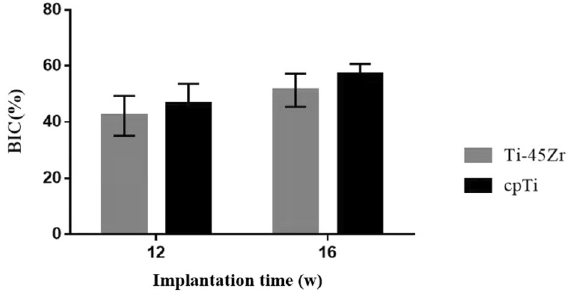
Fig. 14 Comparison of bone-to-implant contact (BIC) percentages